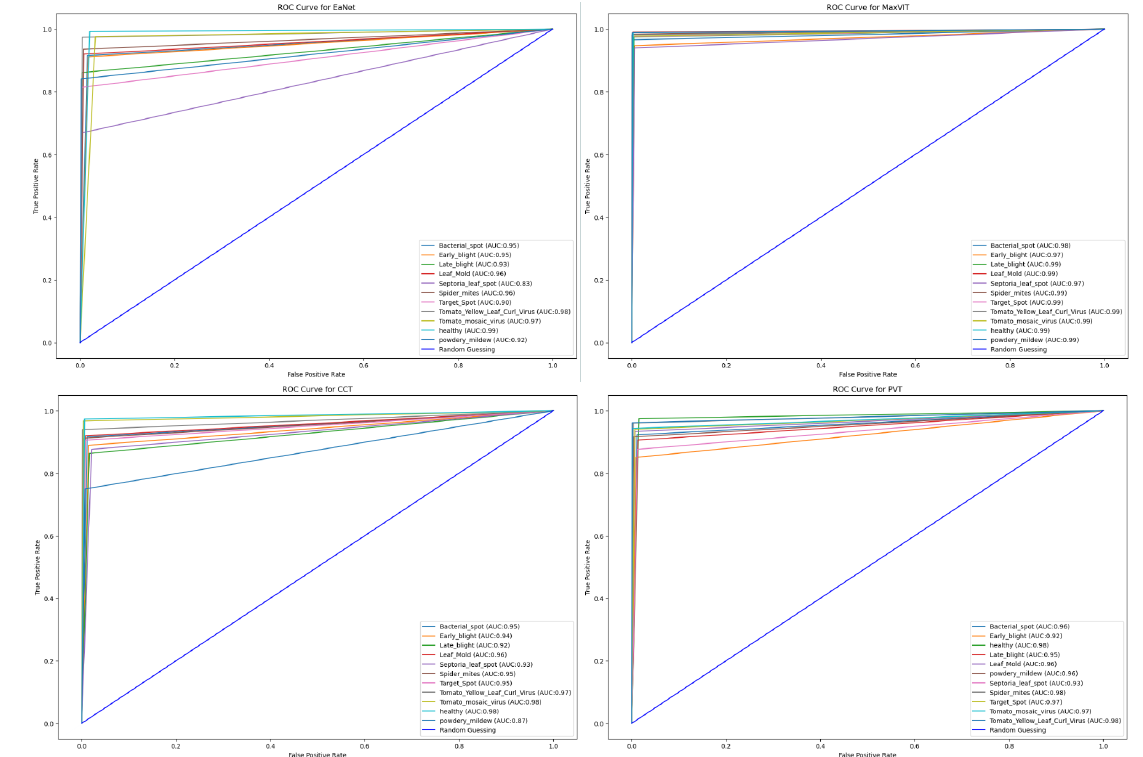
Figure 12. ROC for each of the models.